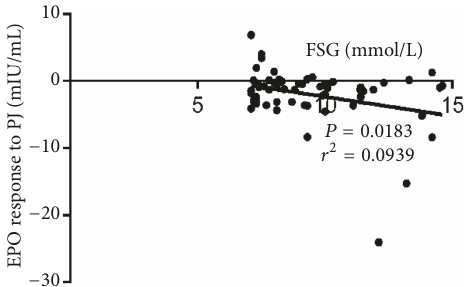
Figure 4: EPO response versus gender of patients with T2D (males, n = 25; females, n =